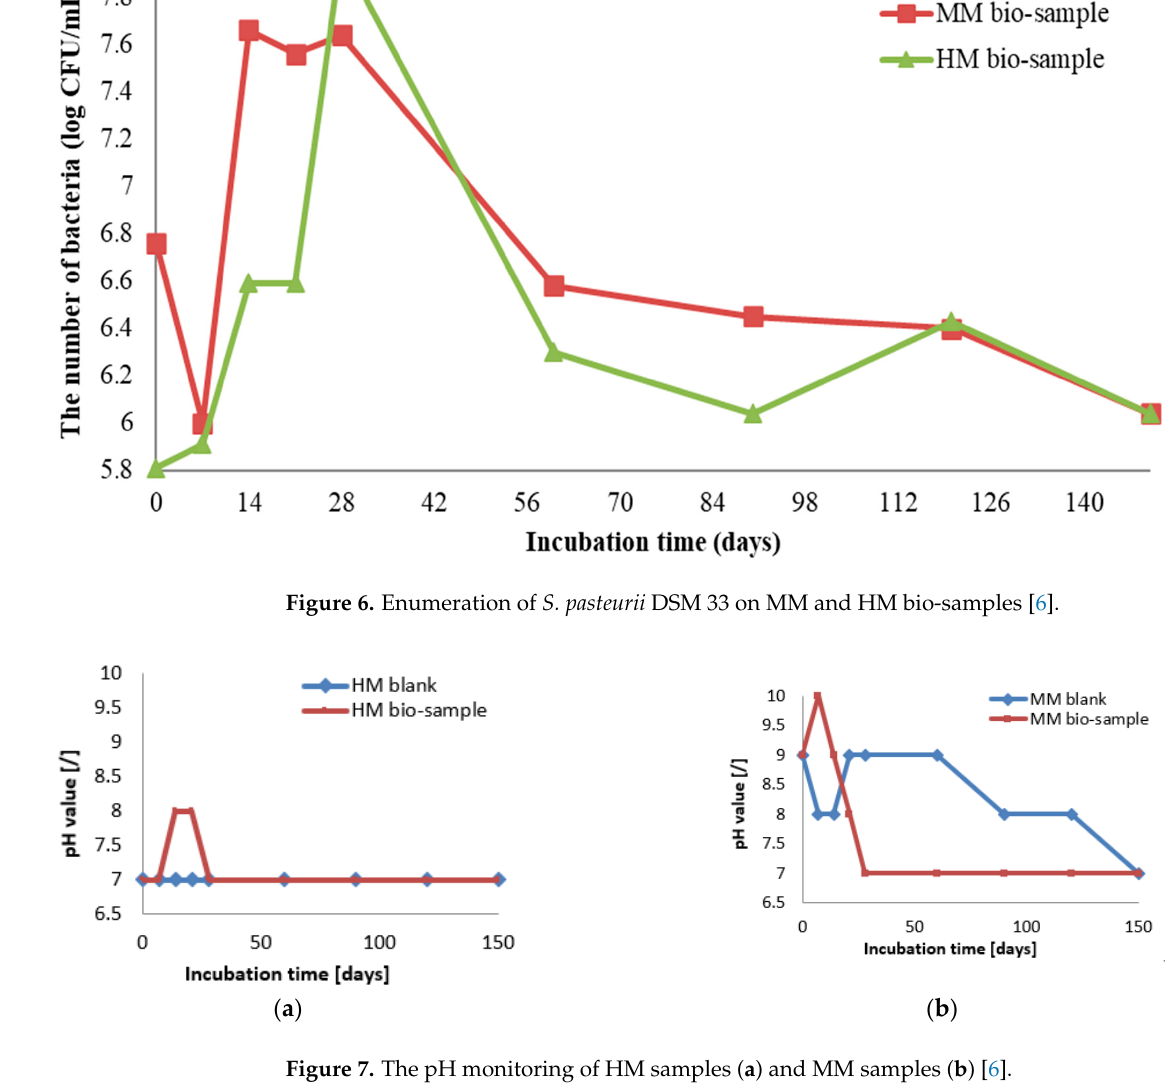
Figure 6. Enumeration of S. pasteurii DSM 33 on MM and HM bio-samples [6].